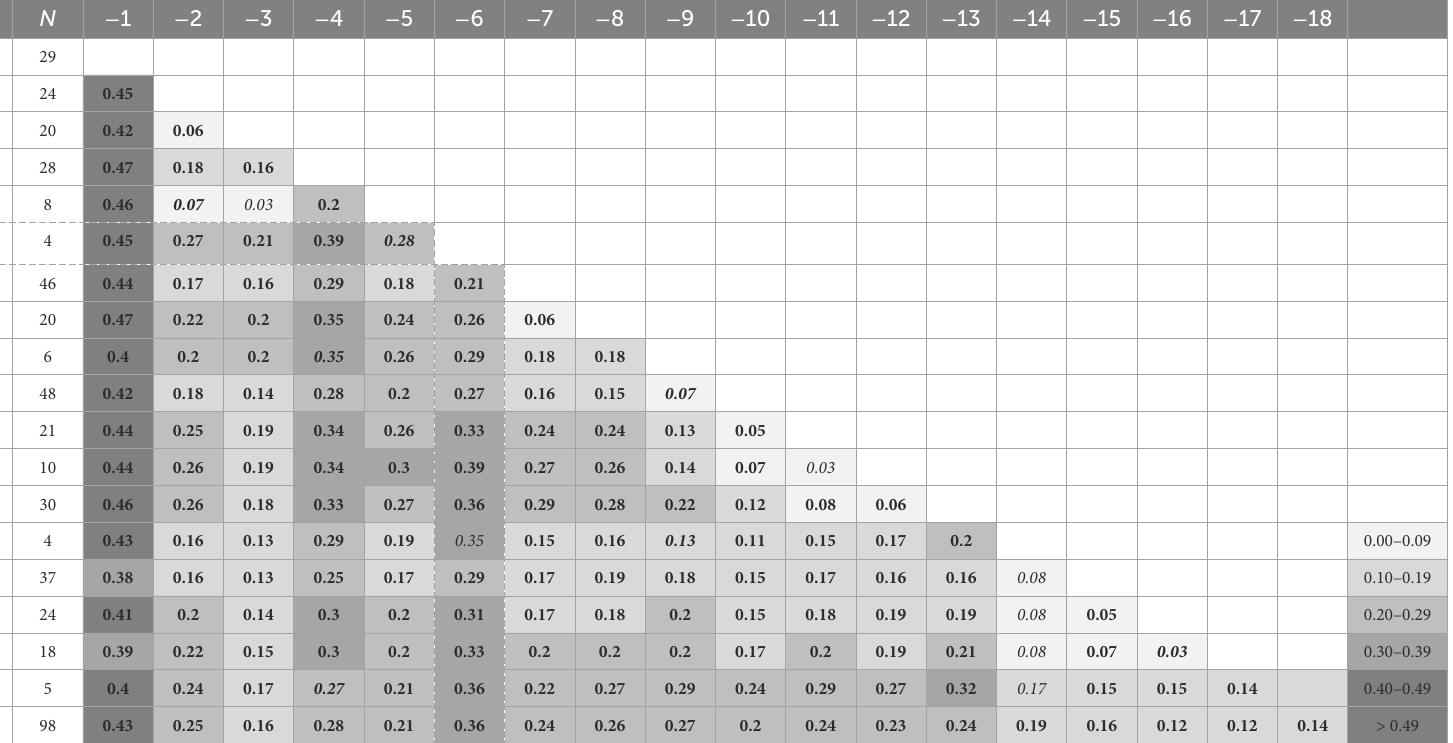
TABLE 1 Pairwise FST values for 19 populations of M. gigantea based on ncSSR data. Locality N